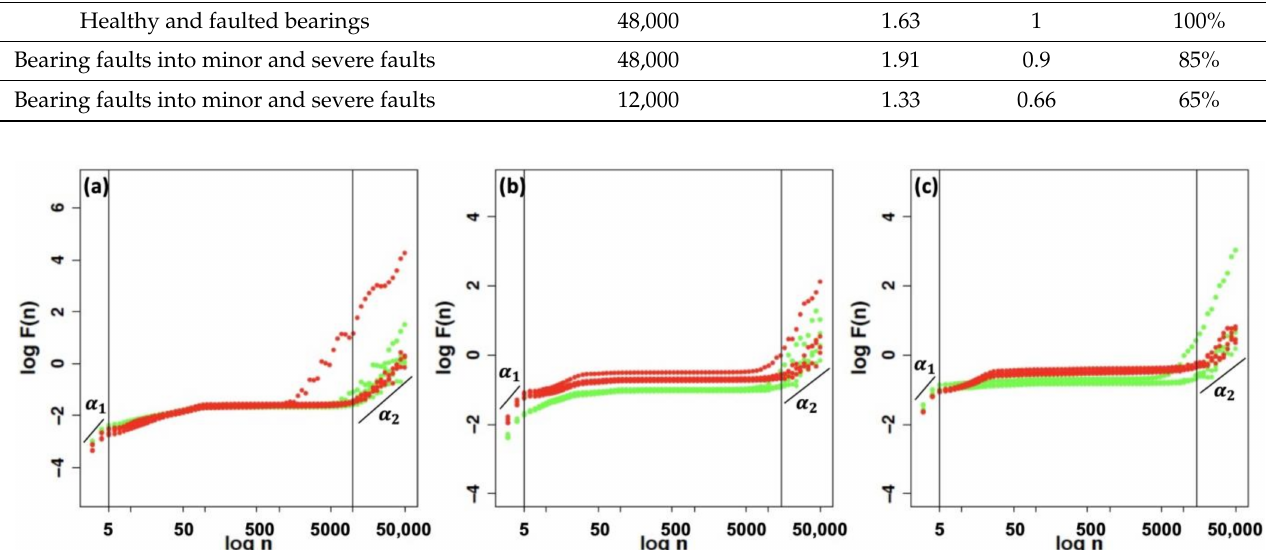
Figure 9. Fluctuation functions ( F ( n ) ) of bearing vibration signals (12,000 samples/s): ( a ) minor (green) and severe (red) ball faults; ( b ) minor (green) and severe (red) inner race faults; ( c ) minor (green) and severe (red) outer race